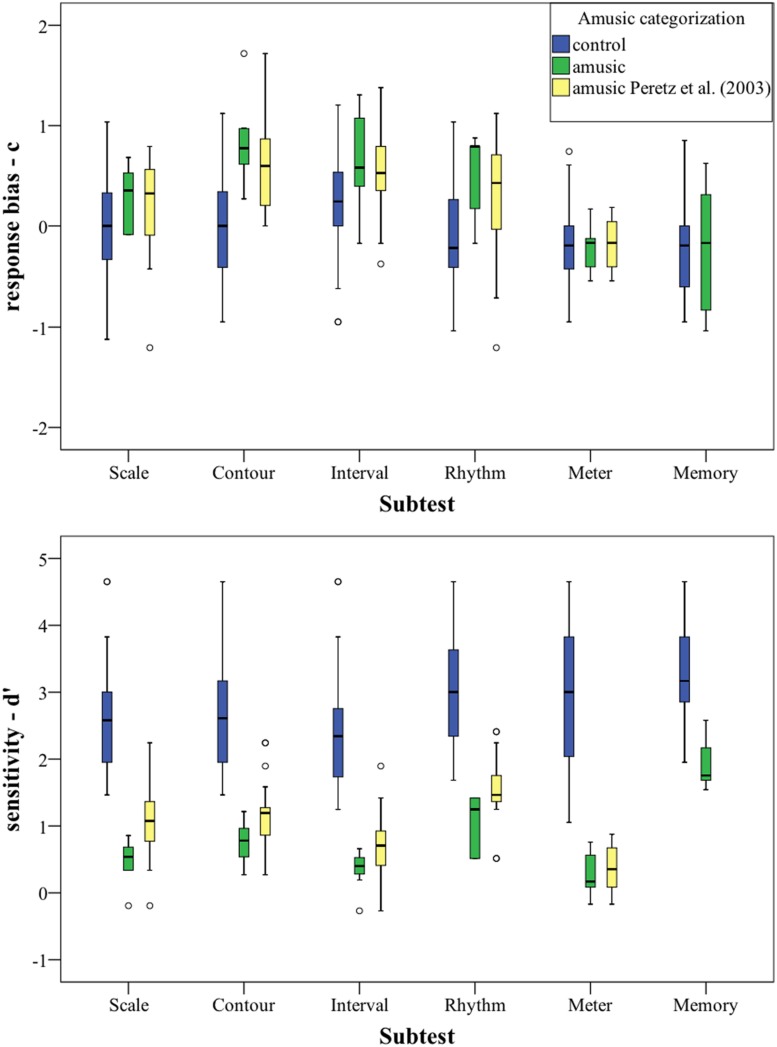
Signal Detection Theory (SDT) scores (d′ and c) plotted per subtest. Categorization based on PC-scores. For statistics, cf. Table 8.